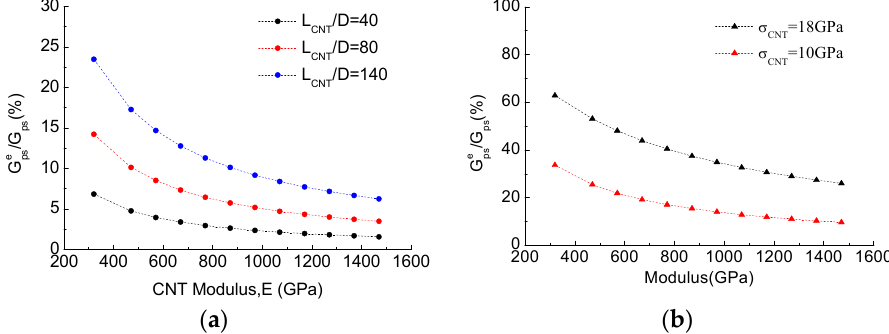
Figure 8. Effect of CNT elastic deformation on energy contribution in different CNT toughening mechanisms: ( a ) CNT pullout; and ( b ) CNT sword ‐ in ‐ sheath.